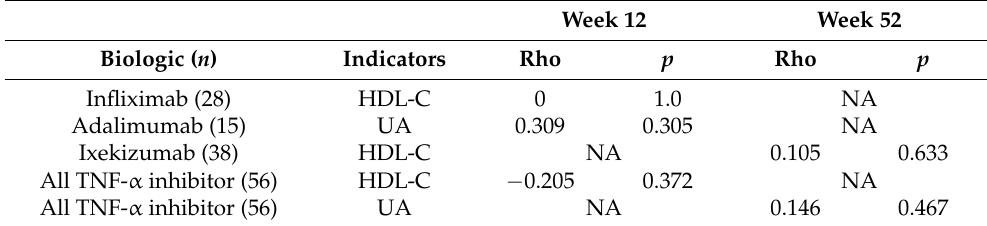
Table 6. Correlations between percent reduction of PASI versus percent changes of HDL-C or